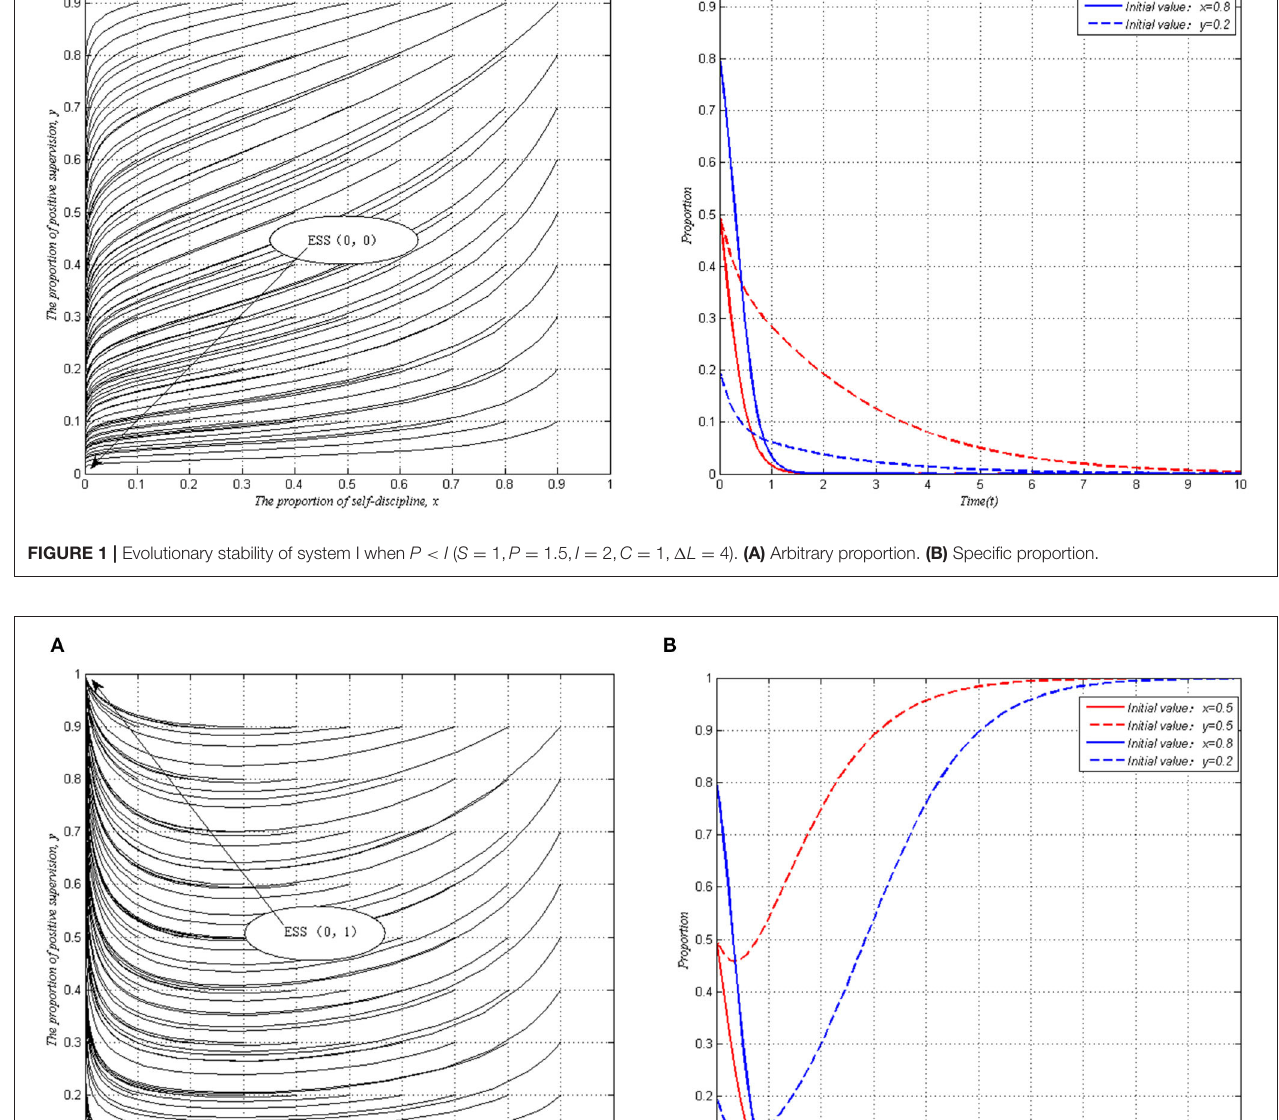
S ( S 1 L 1, P 3, I 2, C 1, 1 L 4). (A) Arbitrary proportion. (B) Specific proportion. + − = = = = =